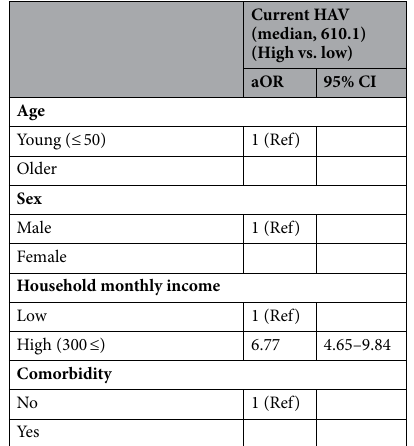
Table 2. Associations of demographic characteristics with current health asset value in the participants ( n = 1000), multiple stepwise model. HAV health asset value, aOR adjusted odds ratios, CI confidence interval, Ref reference.